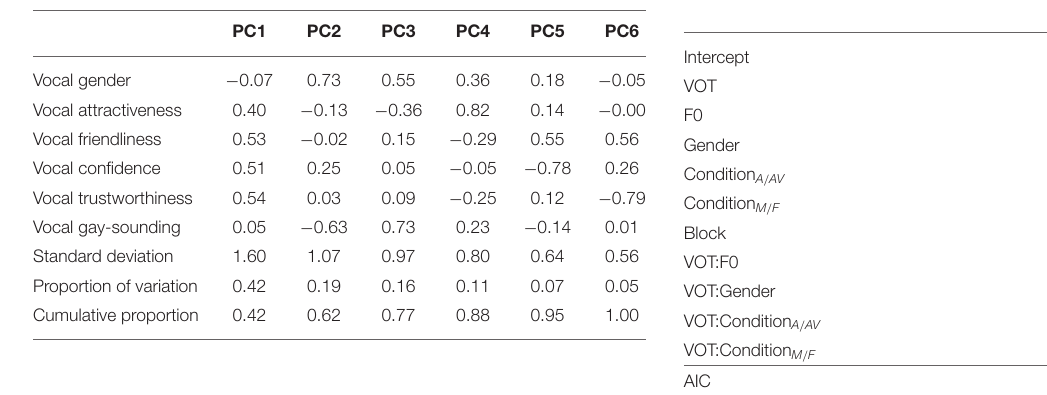
TABLE 2 | The cumulative proportion of variance accounted for and loadings from the PCA of the vocal impression ratings.